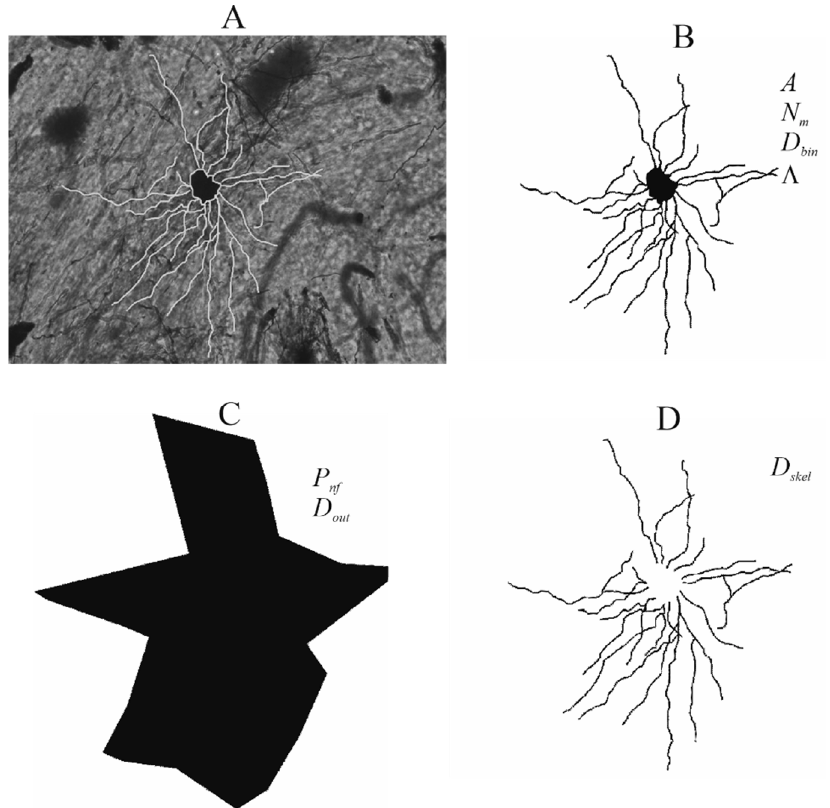
Figure 1. ( A ) A multipolar neuron in gray-scale with a delineated body and a dendrite line of the same ( B ) A gray-scale multipolar neuron converted into a binary image whose body is filled with black pixels. Symbols A , N m , and Λ indicate the parameters to be calculated. ( C ) A binary-outline image constructed around the ends of the dendrites that define the neural field. The symbols P nf and D out are the parameters that quantify the neuronal field. ( D ) A binary-skeletonized dendritic image of a binary image from which a body has been removed. Dendrites are displayed with a single-wide pixel line, and the D skel represents a parameter that quantifies this image.